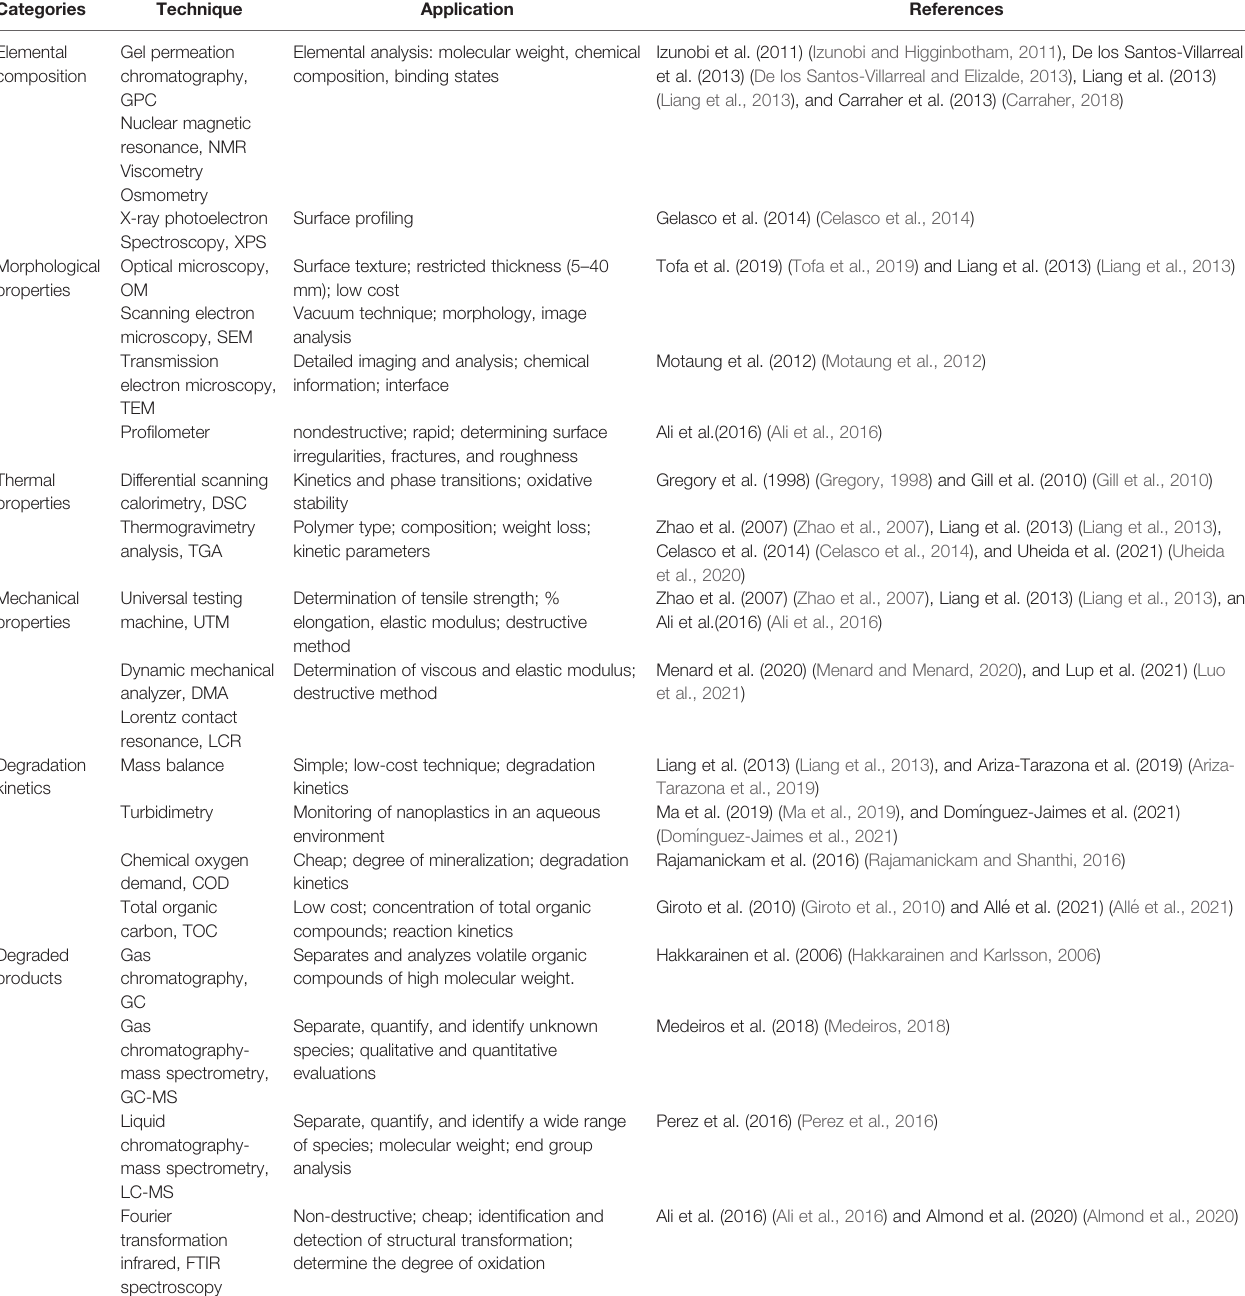
TABLE 3 | General techniques for characterization of